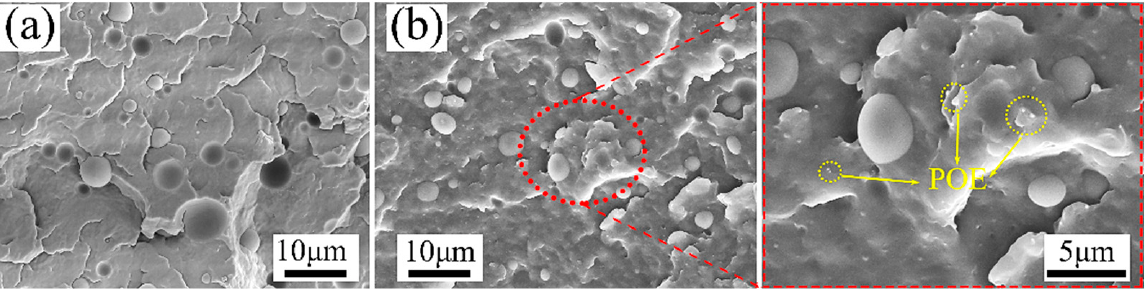
Figure 4. SEM images of the melt-blended composites cryogenic fractured surfaces: ( a ) PP/PET(S), ( b ) PP/PET/POE(S).